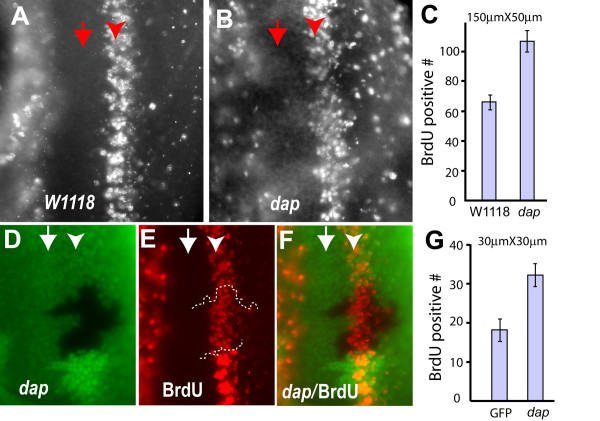
Dap is important for normal cell cycle arrest of cells exiting the SMW. BrdU incorporation of w1118 (A), dap mutant (B) eye discs, and eye discs with dap mutant clones (D-F). (C) Quantification of BrdU positive cells in w1118 and dap mutant eye discs. BrdU positive cells within an area of 150 μm × 50 μm along the SMW from 5 eye discs were counted. (G) Quantification of BrdU positive cells within a 30 μm × 30 μm area in dap mutant clones or adjacent WT tissues. 10 independent dap mutant clones and adjacent WT tissues were analyzed.